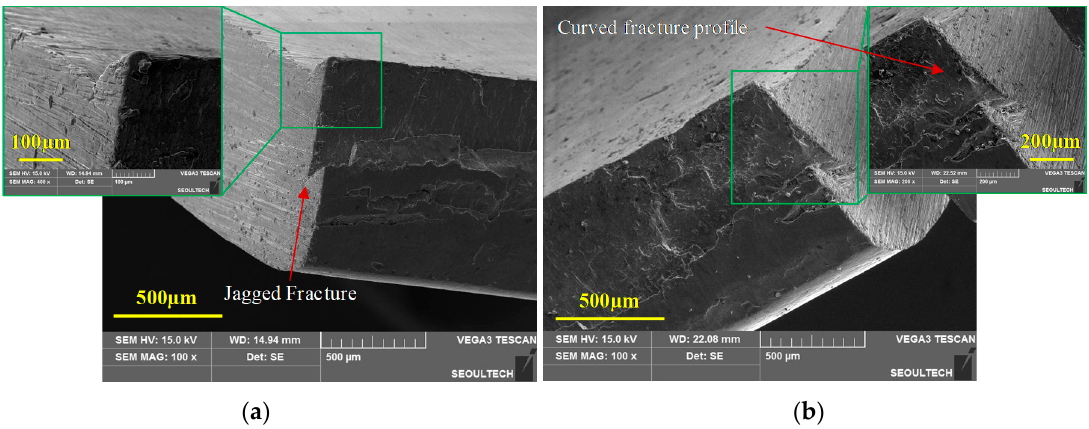
Figure 11. Oriented view (SEM) of the blanked edge obtained from experiments for 20% clearance at 25 °C: ( a ) Side 1, illustrating primary jagged fracture geometry; ( b ) Side 2, illustrating secondary curved fracture profile.